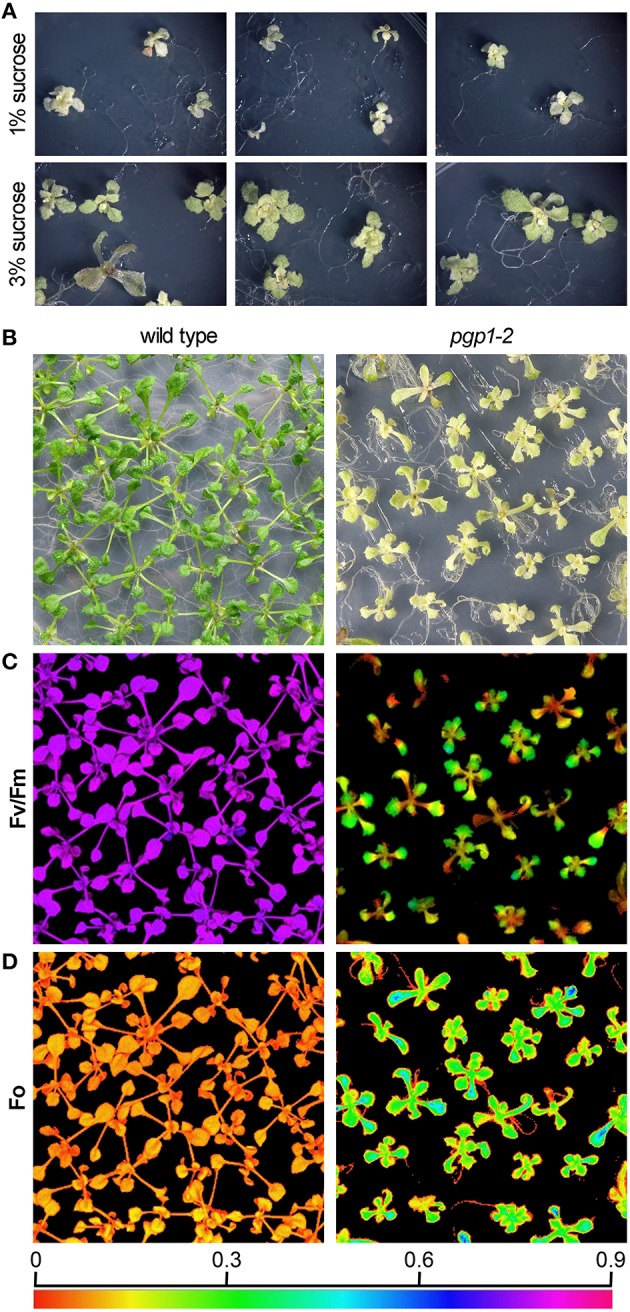
Images of growth and photosynthesis of pgp1-2 mutant plants in the presence of 3% sucrose. (A) Growth phenotypes of pgp1-2 seedlings grown for 21 days on agar media containing 1 or 3% sucrose. (B) Comparison of growth of 21-days-old pgp1-2 seedlings with 14-days-old wild type. (C,D) Images of (C) maximum quantum yield (Fv/Fm) and (D) minimum chlorophyll fluorescence (Fo) in dark-adapted seedlings. Seedlings were the same as shown in (B) for both wild type and pgp1-2 plants. The color in (C,D) represents the value of each parameter in the color scale.